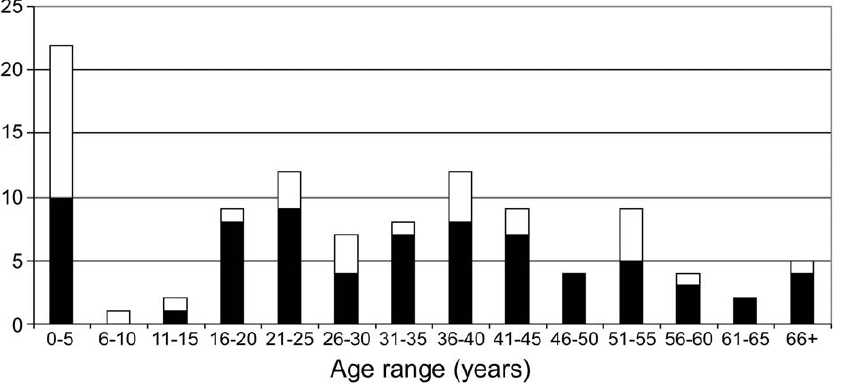
Figure 4. Age and gender distribution of positive cases. Positive cases identified during the operation of the field lab are shown separated by age and gender (female & and male % ). The distribution of positive cases demonstrates a higher proportion of females (68%) and children, 0 to 5 years, (21%) among the infected individuals.